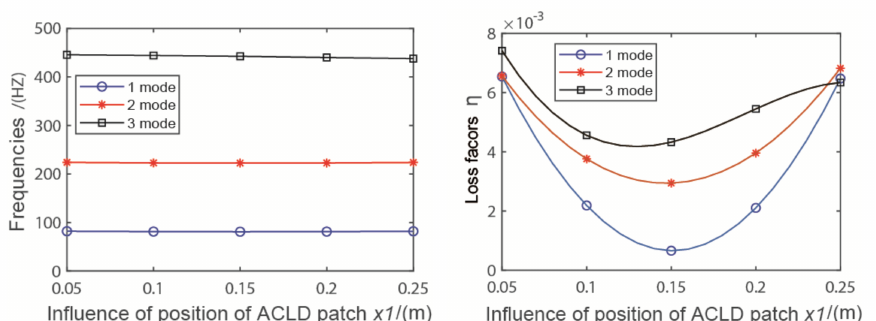
Figure 12. The influence of different position of ACLD